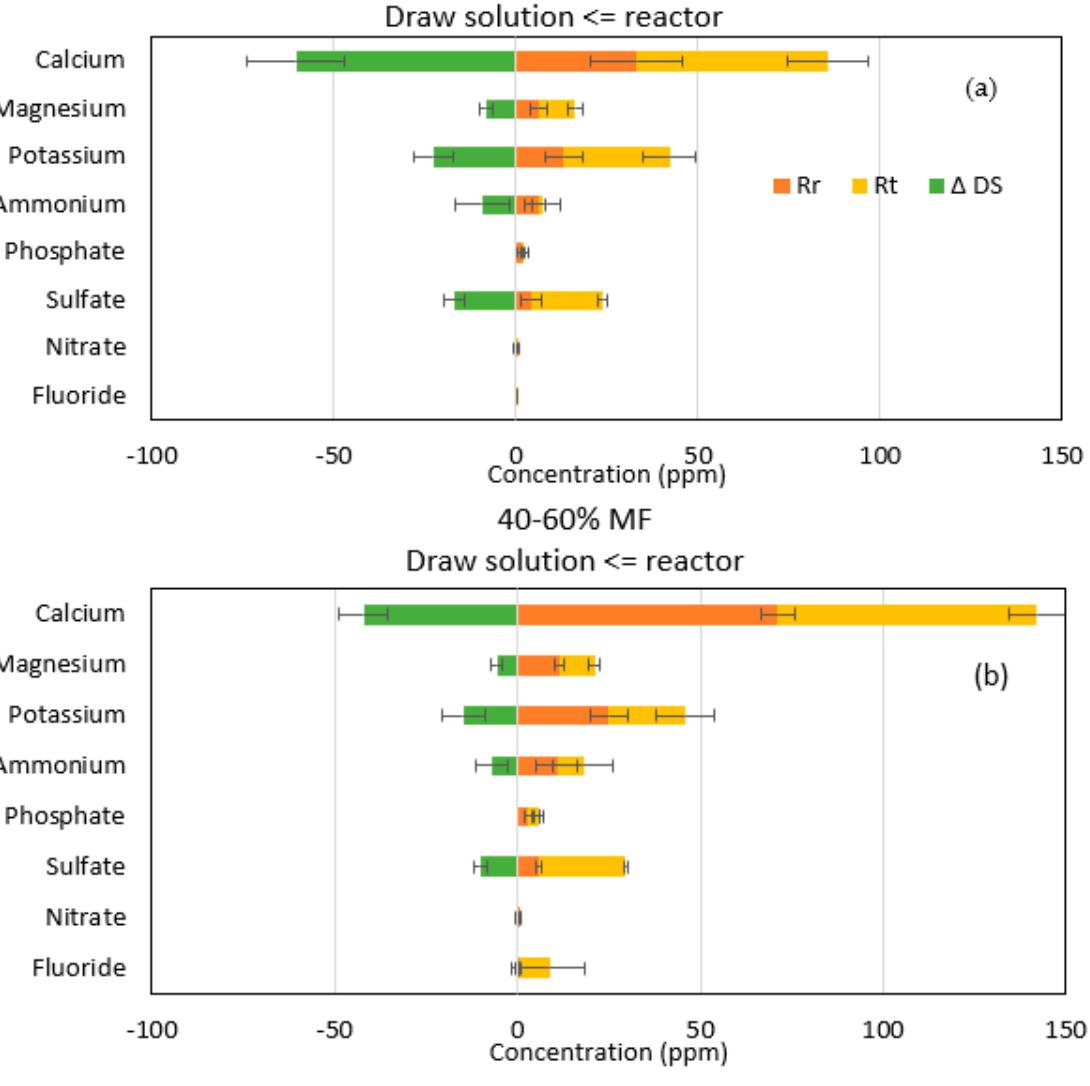
Figure 4. Representation of ion transfer during ( a ) 70% MF and ( b ) 40–60% MF steps. Rr (orange), Rt (yellow) and Δ DS (green) represent the measured concentration, the theoretical concentration in the reactor and the increase of concentration in the DS, respectively.